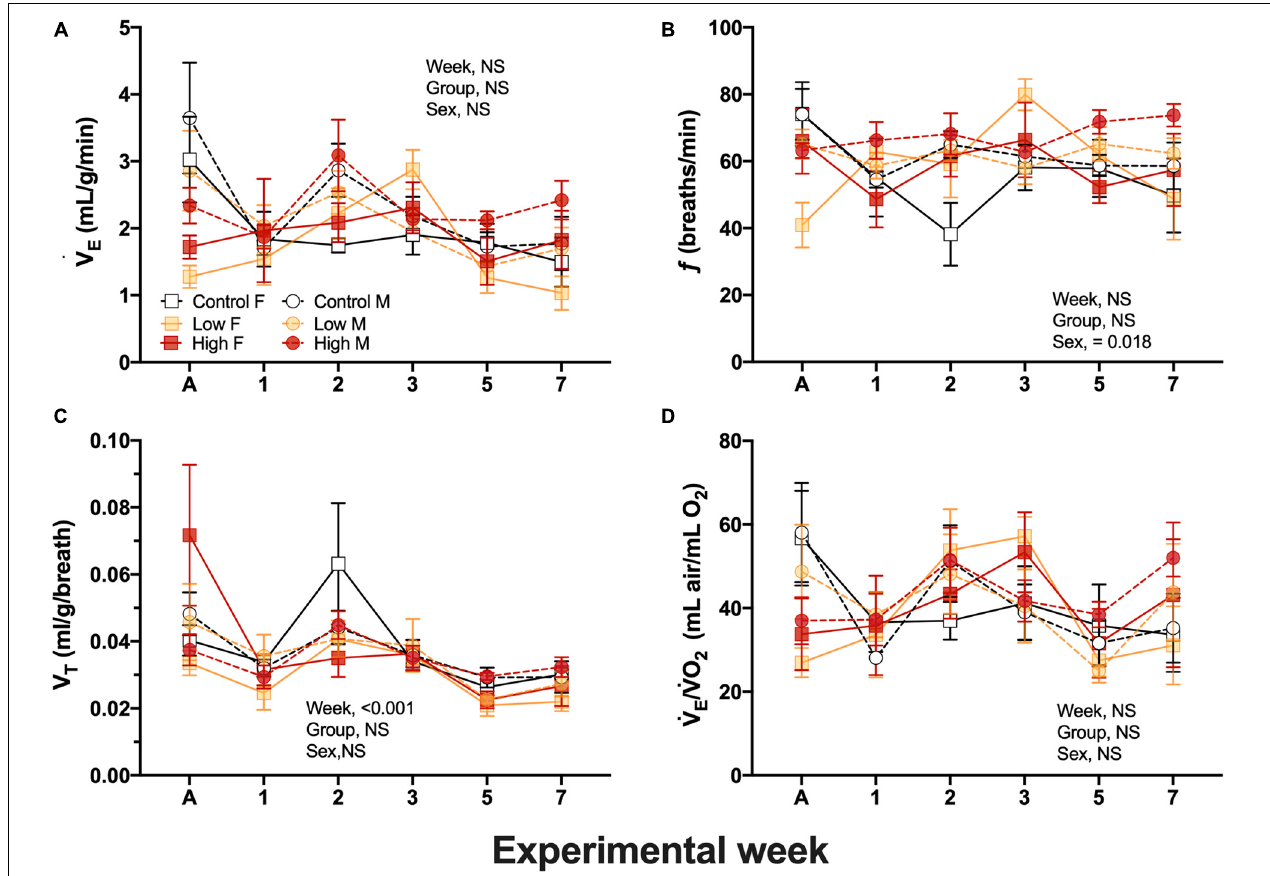
FIGURE 3 | Ventilation variables during experimentation in adult female (squares), and adult male (circles) groups of parental populations of king quail dietarily exposed to Low (1%HEWAF, yellow symbols), High (10% HEWAF, red symbols), and Control (white symbols). (A) Minute ventilation (˙V E ). (B) Breathing frequency ( f ), (C) Tidal volume (V T ). (D) Air convection requirement (˙V E /˙VO 2 ). Data are expressed as mean ± 1 standard error of the mean. Statistical significance was considered to be α = 0.05. n = 3–5 per data point.